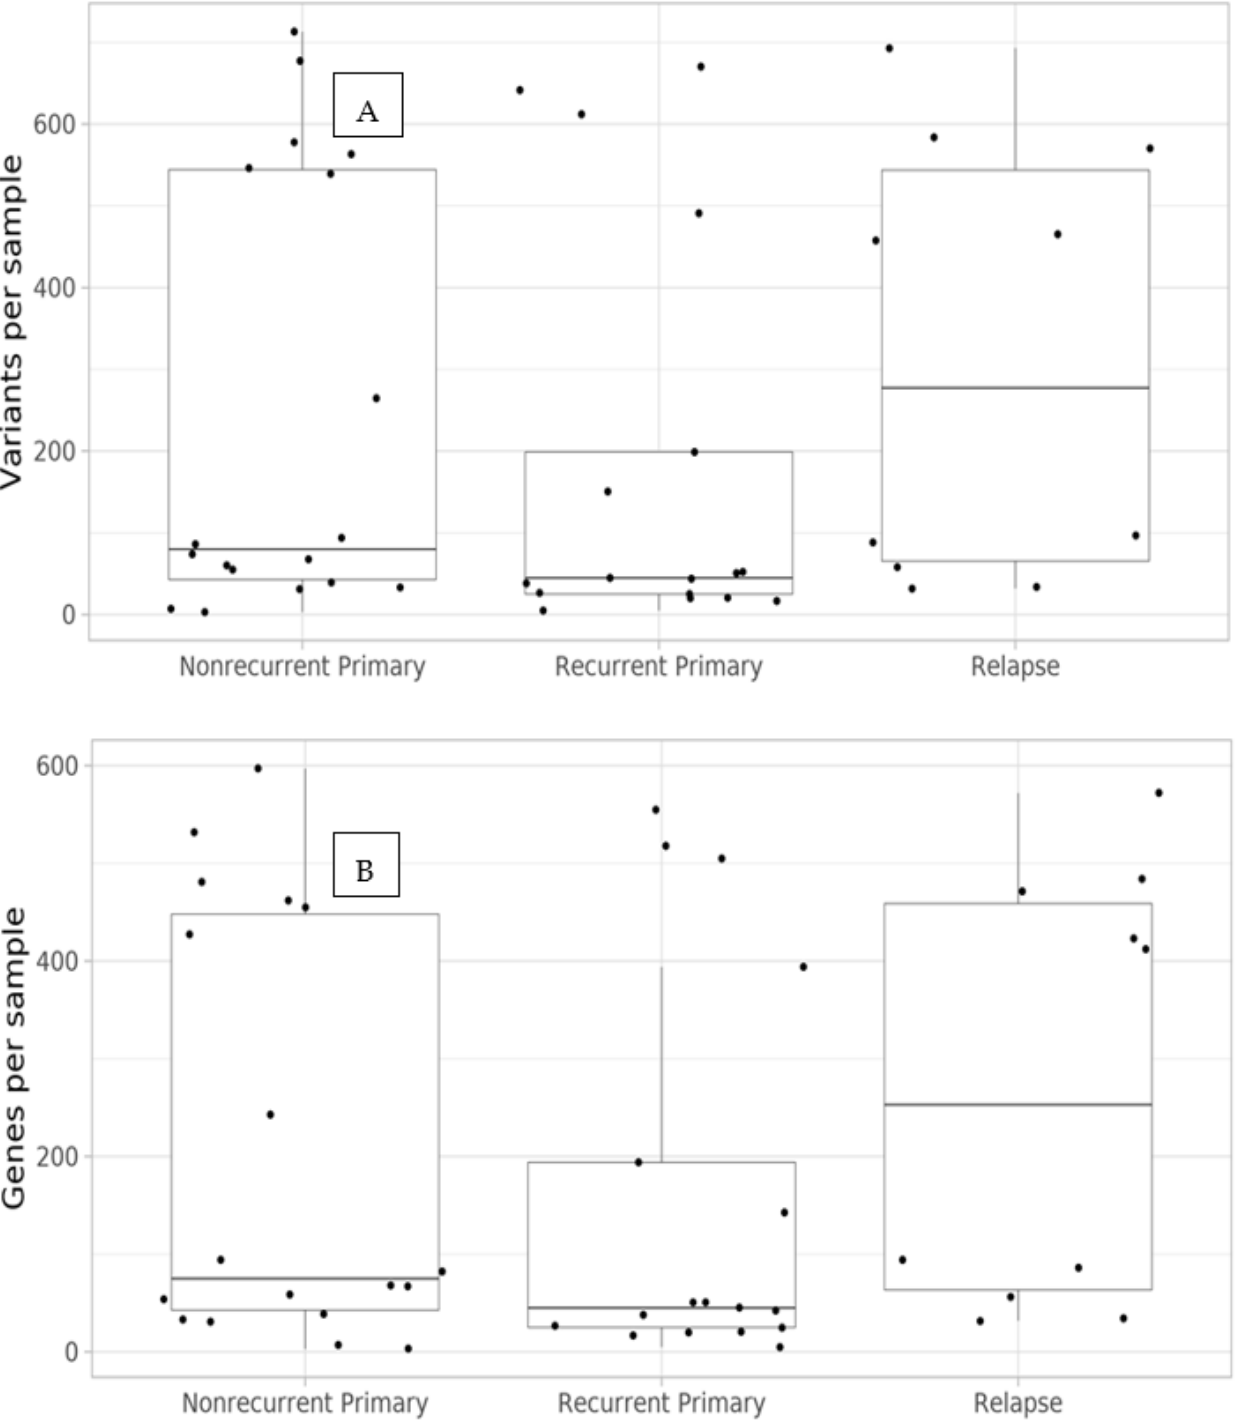
Figure 1. Numbers of identified variants ( A ) and genes impacted ( B ) per sample and cohort. “Nonre- current Primary” refers to primary tumours from patients without a local/distant tumour relapse after treatment. “Recurrent Primary” refers to primary tumours from patients with a local/distant relapse after treatment, and “Relapse” refers to corresponding local or distant tumour relapse in these patients.